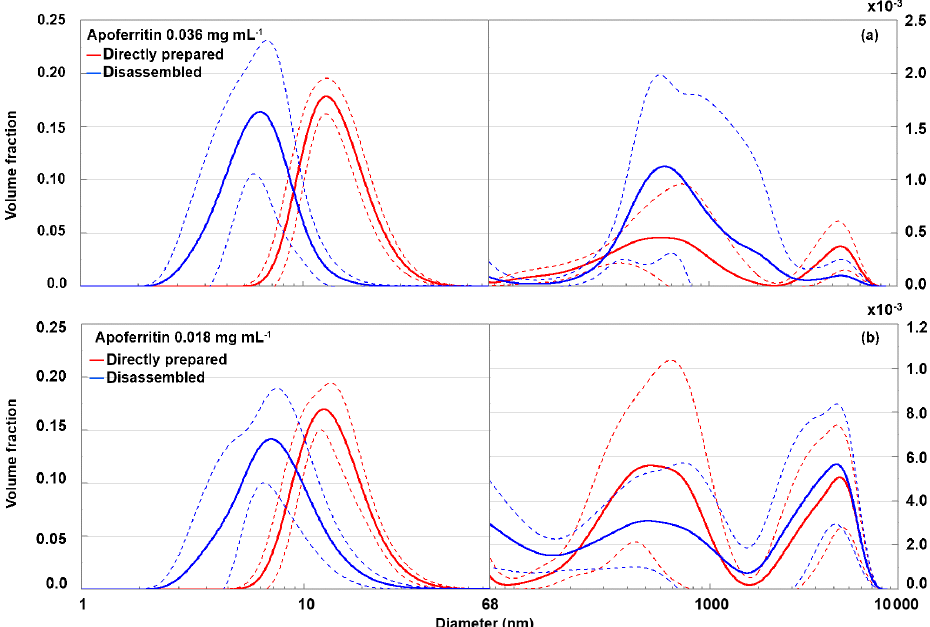
Figure 10. Volume-weighted distribution of directly prepared (red) and disassembled (blue) apoferritin, batch 2, with concentrations of 0.036mgmL − 1 (a) and 0.018mgmL − 1 (b) . Solid lines are averages of multiple measurements, and dashed lines indicate 1 standard devia- tion.